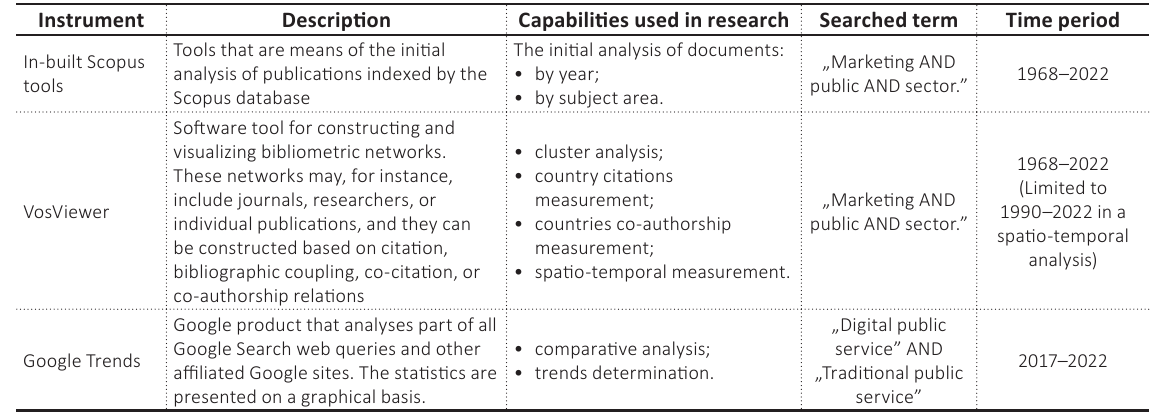
Table 1. Methodological tools and their